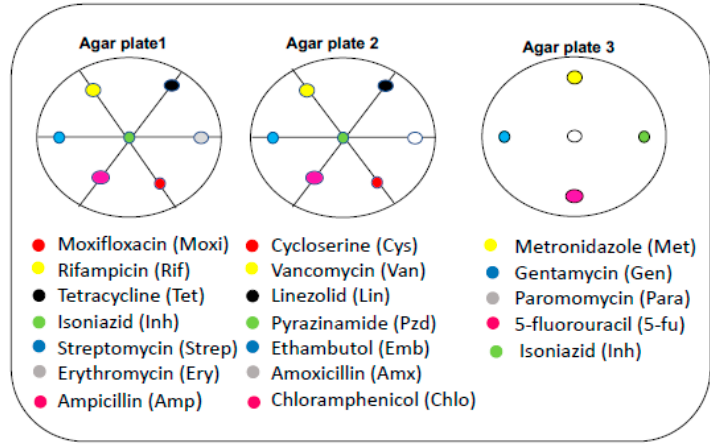
Figure 4. Schematic representation of the arrangement of antibiotic discs on agar plates. A total of nineteen different commercial antibiotics were placed at unique positions on three M7H10 agar plates, which were inoculated with cultures of either Mycobacterium smegmatis mc 2 155 or erythromycin-resistant Mycobacterium smegmatis A. The amount (in µ g) of each selected antibiotic-containing disc is indicated in Table S2 and the amount of each antibiotic (in µ g) used as a neighbor for the selected antibiotic is indicated in Table S3.